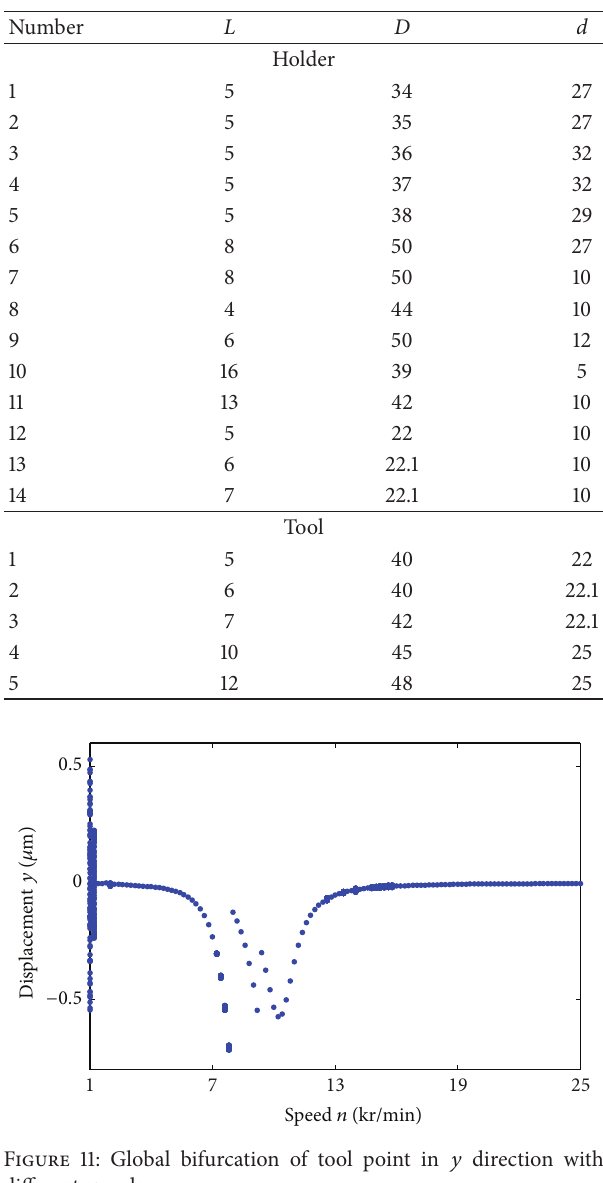
Table 2: The size of motorized spindle in mm. Table 3: The size of holder and tool in mm.